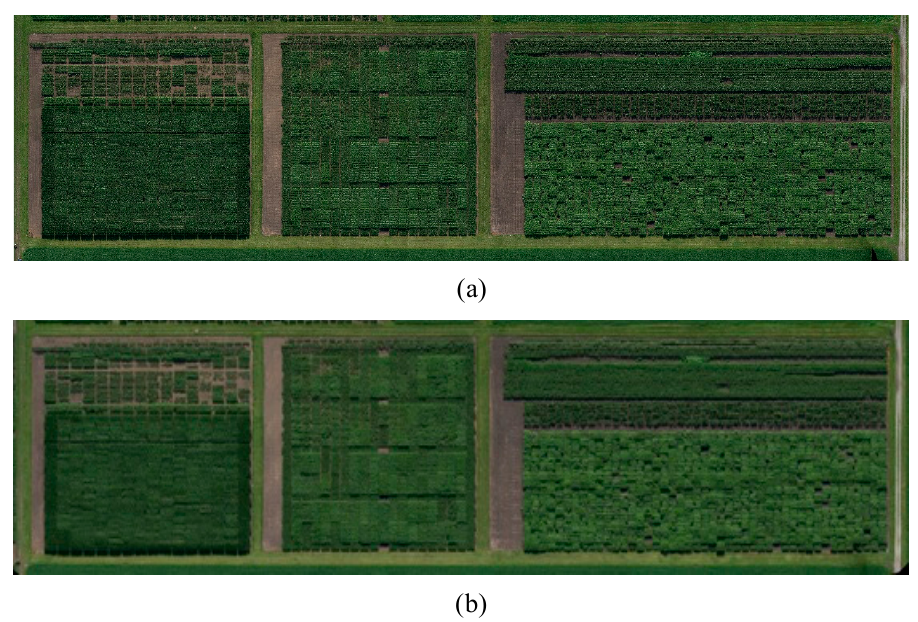
Figure 17. The generated RGB-based orthophoto mosaic from ( a ) the proposed automated aerial triangulation, and ( b ) Pix4D for S1000-Agriculture-1 Dataset.